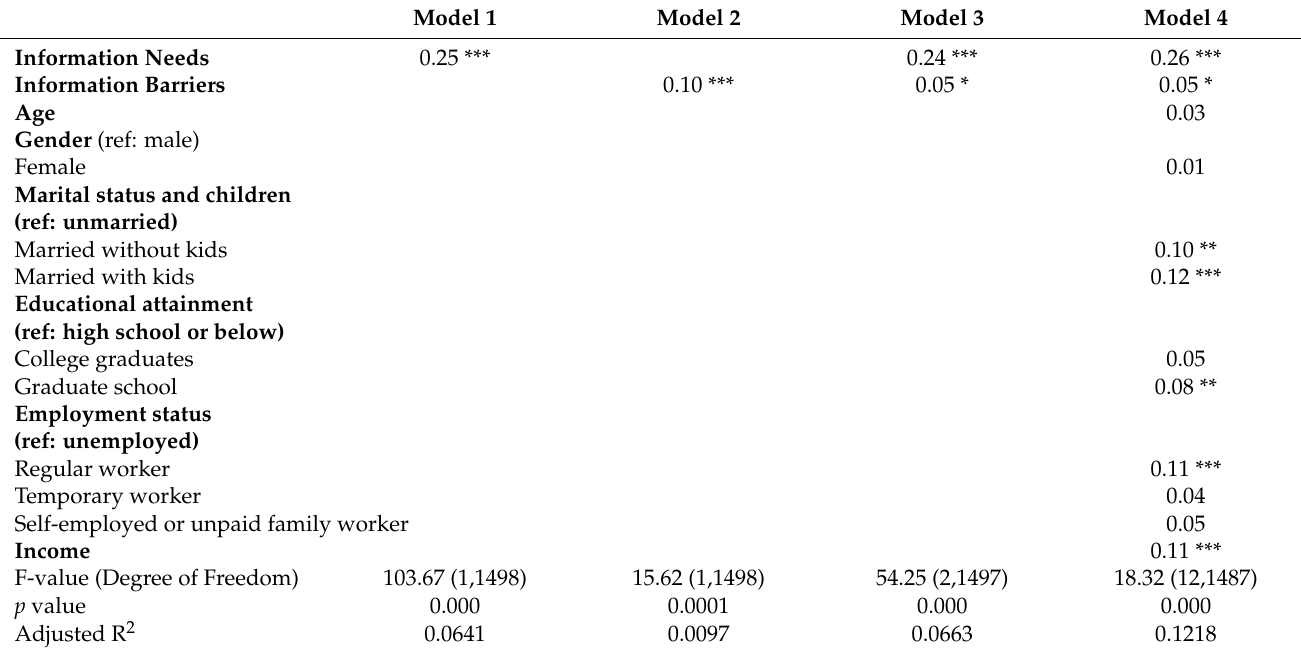
Table 3. Factors associated with the number of sources for seeking COVID-19 information ( n =